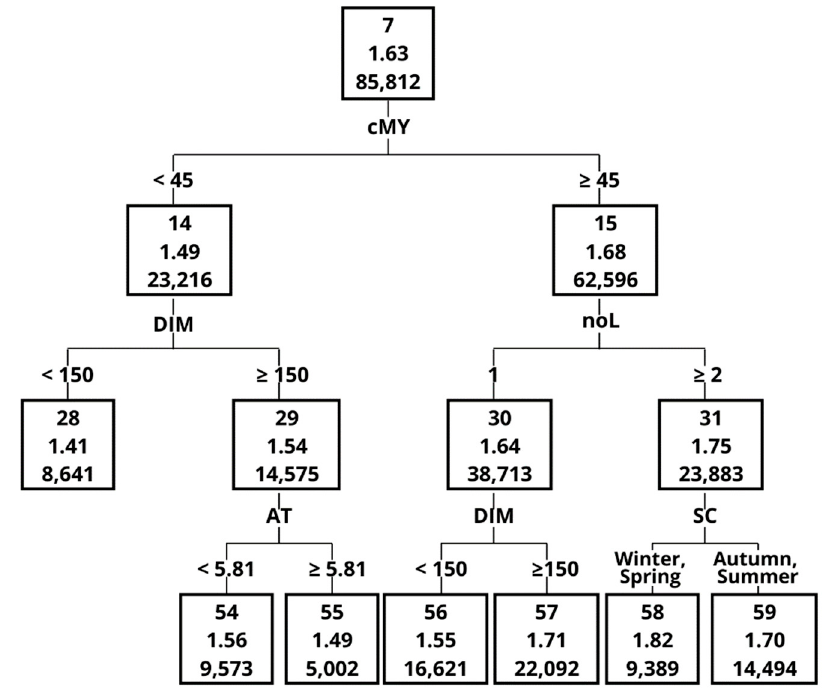
Figure 6. The graphical model of the decision tree—part 5.